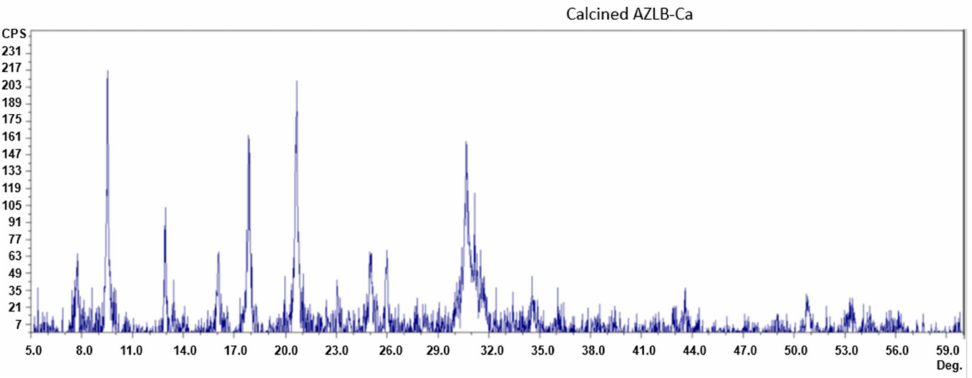
Figure 1. The XRD pattern of calcined AZLB-Ca.